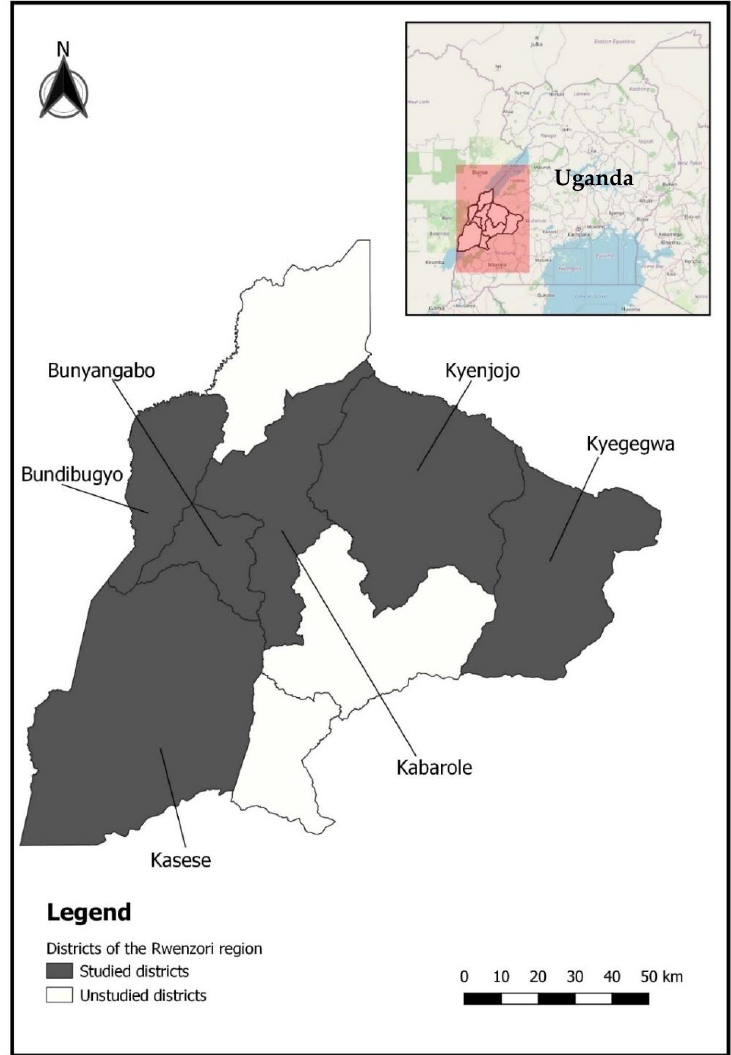
Figure 1. Map of the Rwenzori region showing the districts (with their location in Uganda, see map top right) where fish farmers were interviewed (grey) and where no fish farmers were interviewed (white). Bunyangabo is a former county of Kabarole that was established as an independent district in 2017. In this study, those two districts were studied together as Kabarole district where complete fish farmers’ lists were still held.